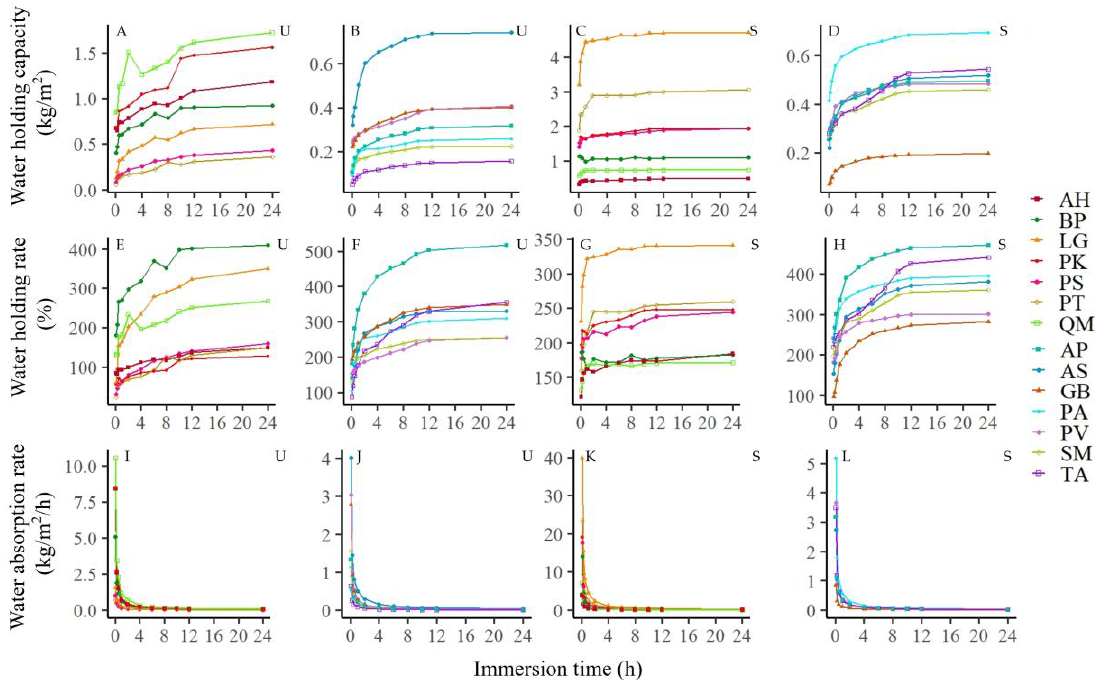
Figure 2. Relationship between litter water holding capacity ( A – D ), water holding rate ( E – H ), water absorption rate ( I – L ), and immersion time (h) of different tree species in different decomposed layers. Note: U indicates un-decomposed layer and S indicates semi-decomposed layer. Please see Table 1 for the abbreviation of tree species.